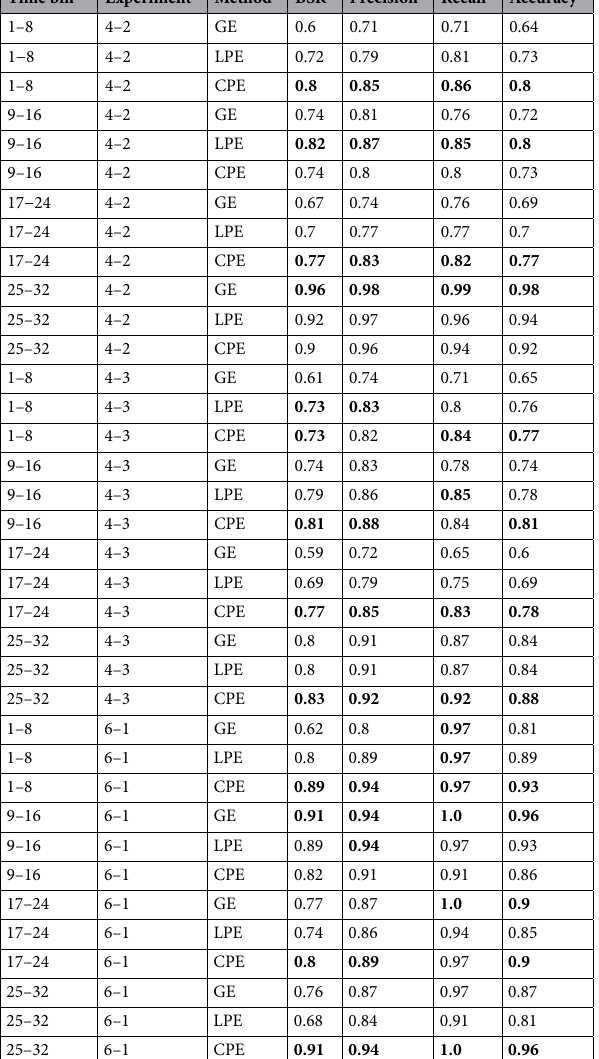
Table 1. Classification statistics by method, experiment and time bin on the test data sets. Pathway expression methods generally produce a higher BSR, precision, recall and accuracy over gene expression methods with the SVM feature selection technique. CPE is computed using pre-computed edges with PageRank centrality. The highest statistic for each time bin is bold face. All experiments apply LIMMA using subject identifier to the data. Standard deviation is not available for these statistics due to the design of our LOSO experiments. See the Methods section for